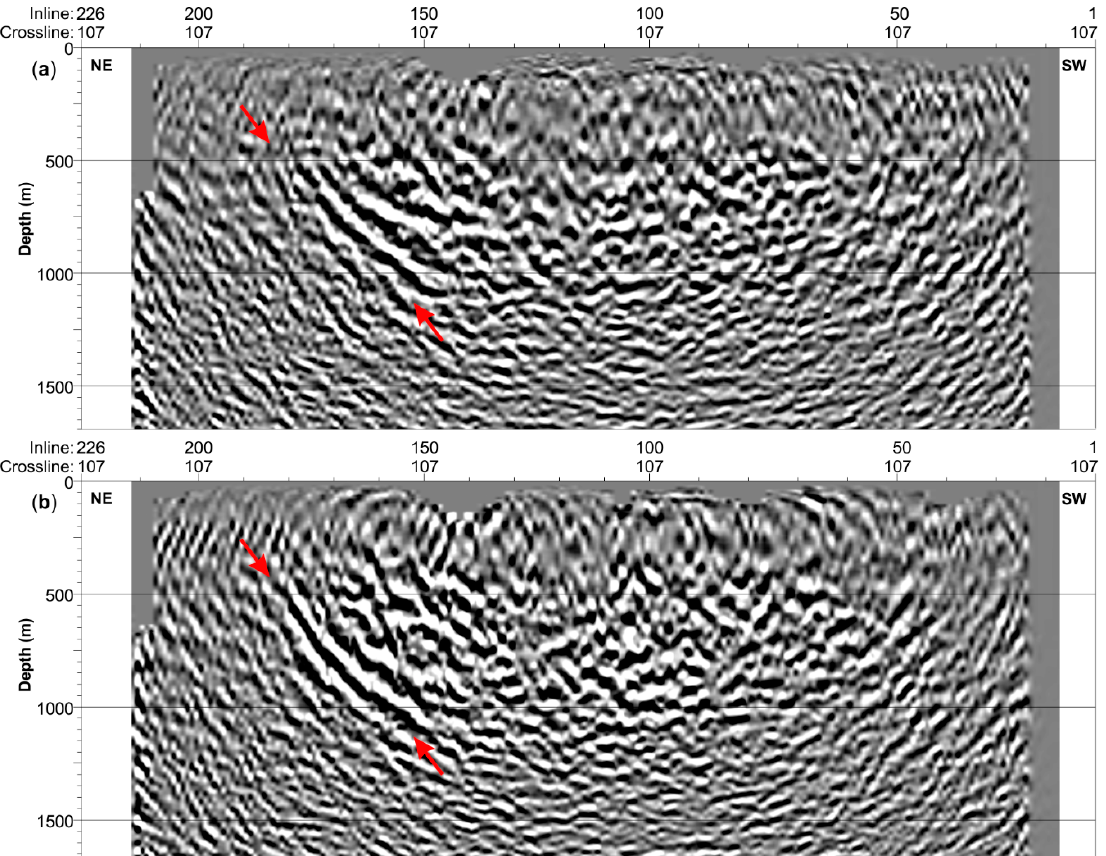
Figure 6. Crossline along the ore zone from Kirchhoff pre-stack depth migration (KPreSDM) using the velocity model build with ( a ) raw picks; ( b ) picks corrected with refraction statics. Note the better focusing in (b) and the extent of the dipping reflector shown by red arrows.